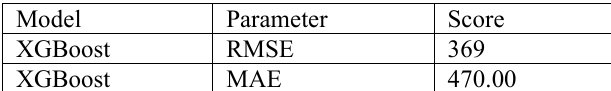
Table 5. Performance Analysis of